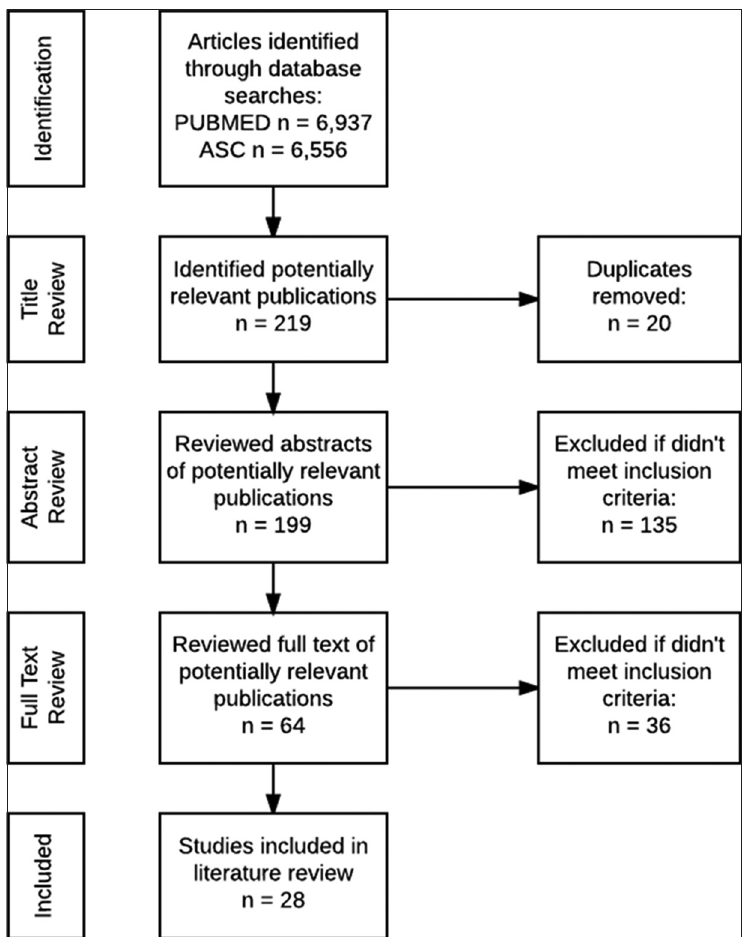
Figure 2: Study Flowchart